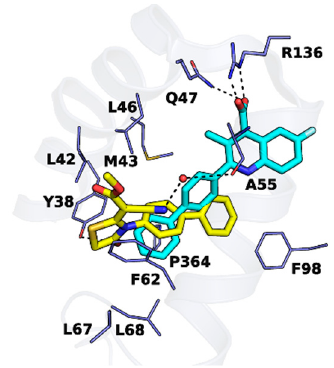
Figure 3. Binding mode of 4-thiazolidinone derivative 9 . Compound 9 is displayed as yellow sticks and brequinar is shown as cyan sticks.